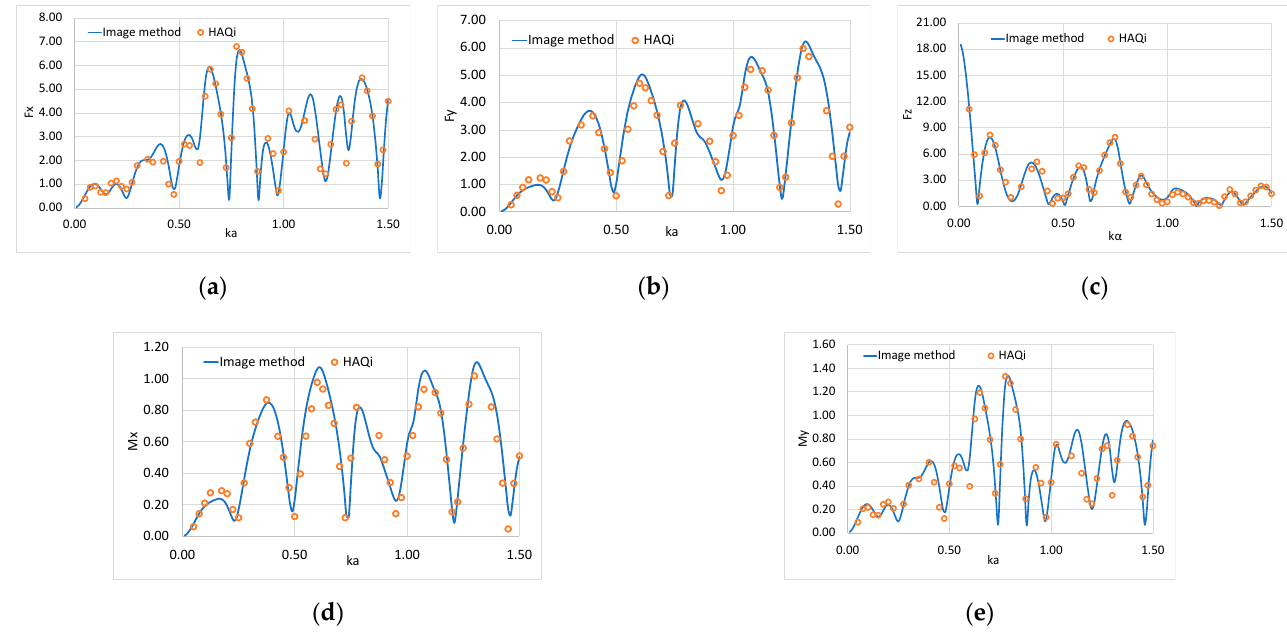
Figure 3. Exciting forces and moments on the converter placed in front of a 60-degree V-shaped breakwater. The results of the method of images are compared with the corresponding ones from an analytical formulation assuming a finite-length breakwater: ( a ) surge exciting forces; ( b ) sway exciting forces; ( c ) heave exciting forces; ( d ) roll exciting moments; ( e ) pitch exciting moments.